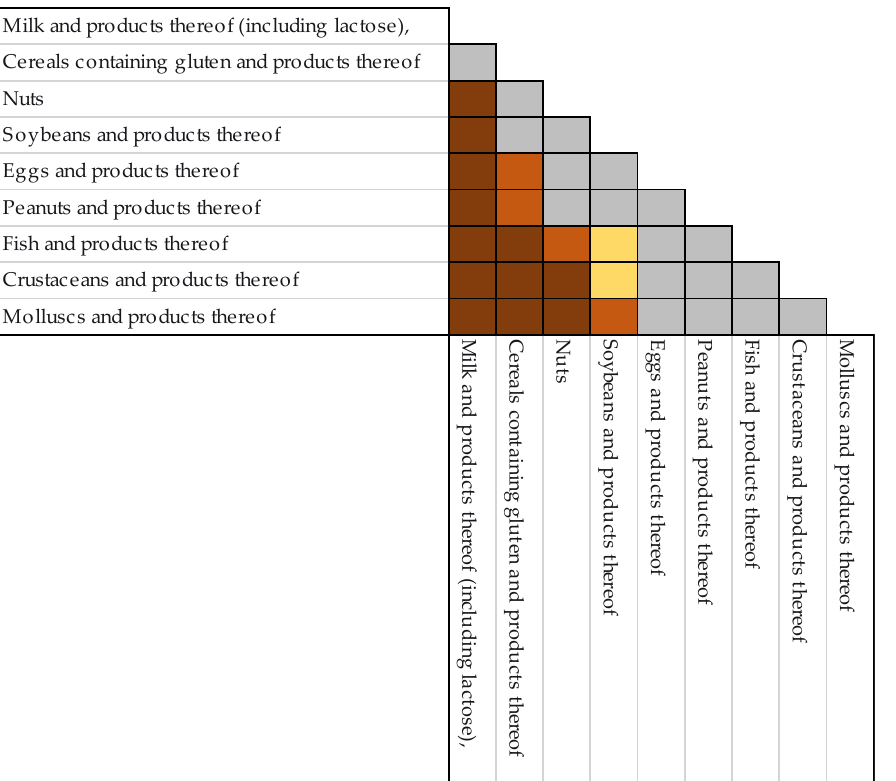
Figure 4. Statistical differences among the undeclared, main pediatric allergens in notifications emitted between 1 January 2018 and 31 December 2021. In grey- no significant differences; in yellow- significant differences with p < 0.01; in orange - significant differences with p < 0.005; and in brown-significant differences with p < 0.001.